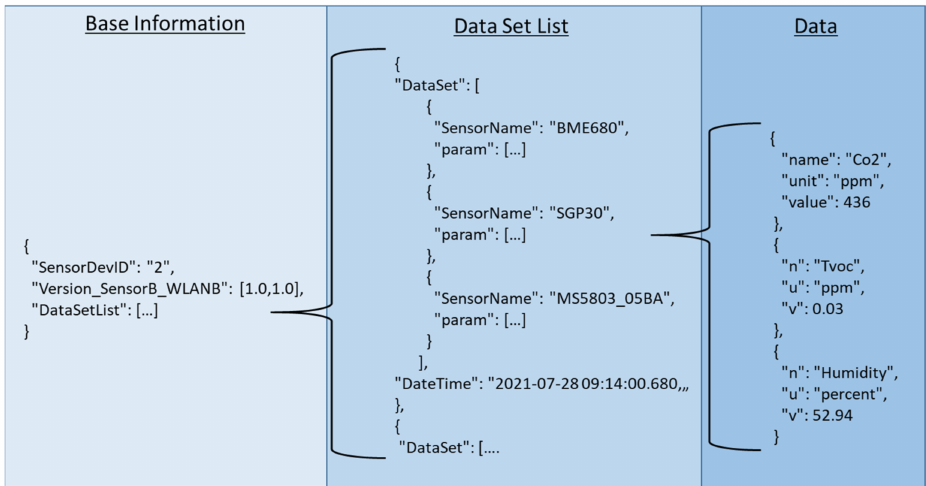
Figure 4. Simplified presentation of the transfer protocol’s structure in JSON-format.